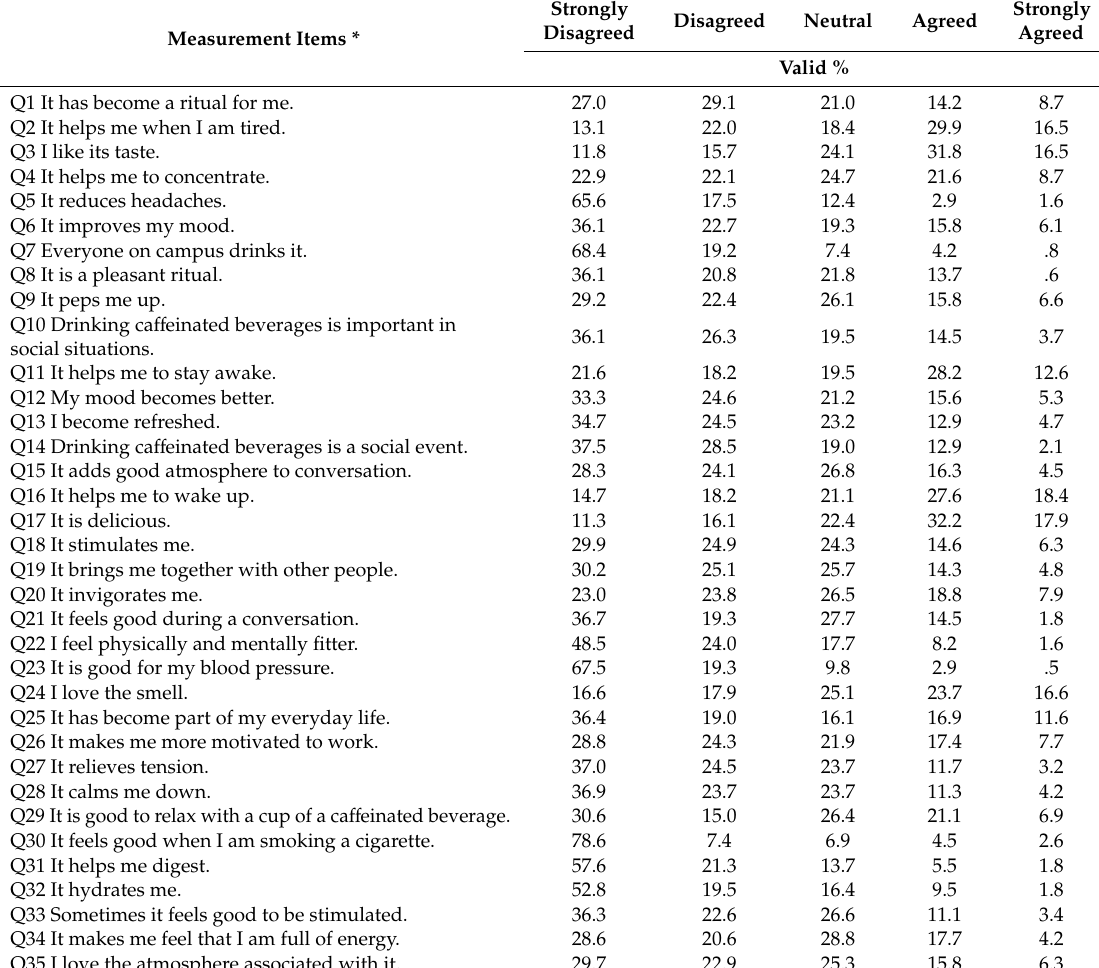
Strongly Agreed